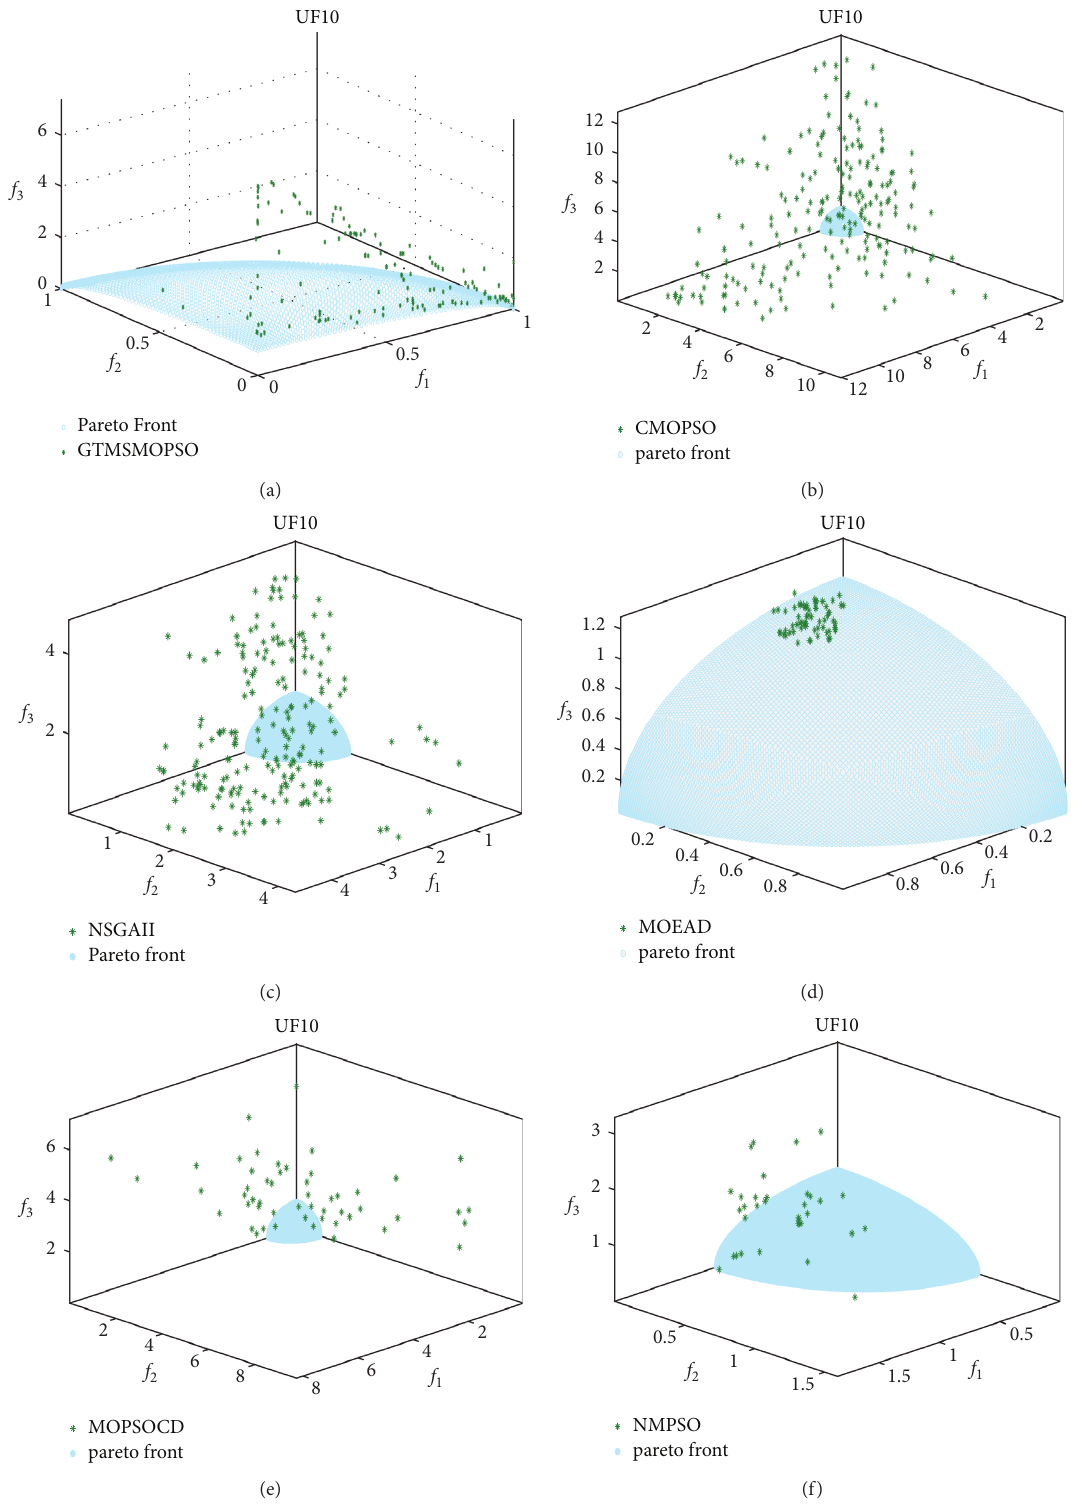
Figure 7: Pareto frontier effect of three different algorithms for UF10